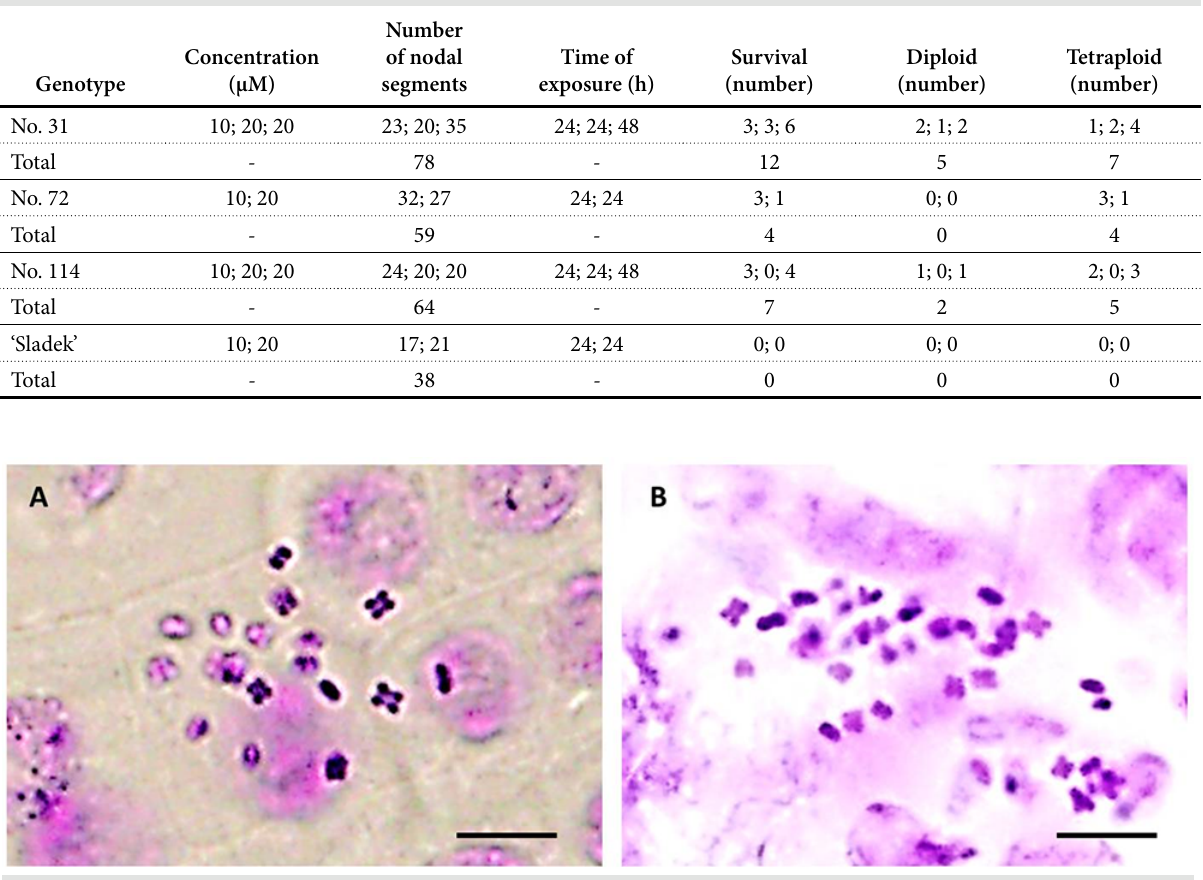
Fig. 2 Chromosome numbers of H. lupulus (Clone 72, Sample 25). ( A ) Diploid control plant (2 n = 2 x = 20). ( B ) Tetraploid plant (2 n = 4 x = 40). Scale bar is 5 µm.